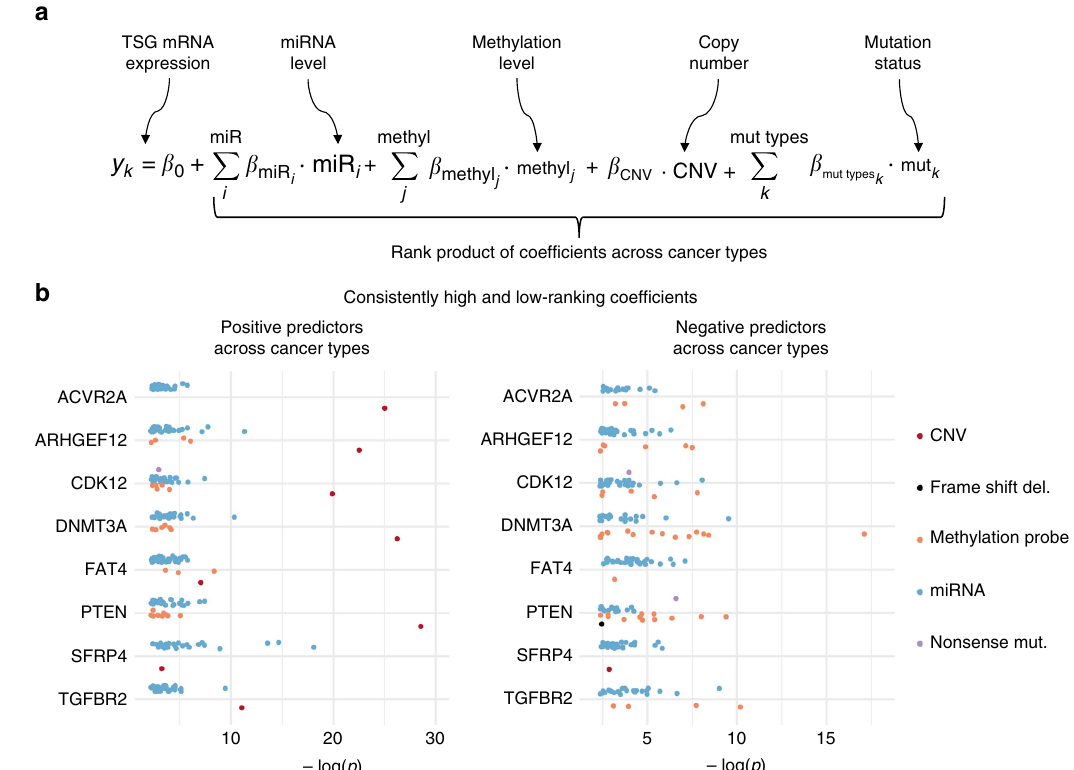
Fig. 3 Approach used in determining the regulation of each TSG identi fi ed as potentially signi fi cantly miRNA-regulated. a The linear model used whilst determining predictors of TSG mRNA expression. b Model coef fi cients were aggregated across cancer types with the rank product statistic, and those identi fi ed as statistically signi fi cant positive and negative predictors are depicted alongside the -log of their rank product p